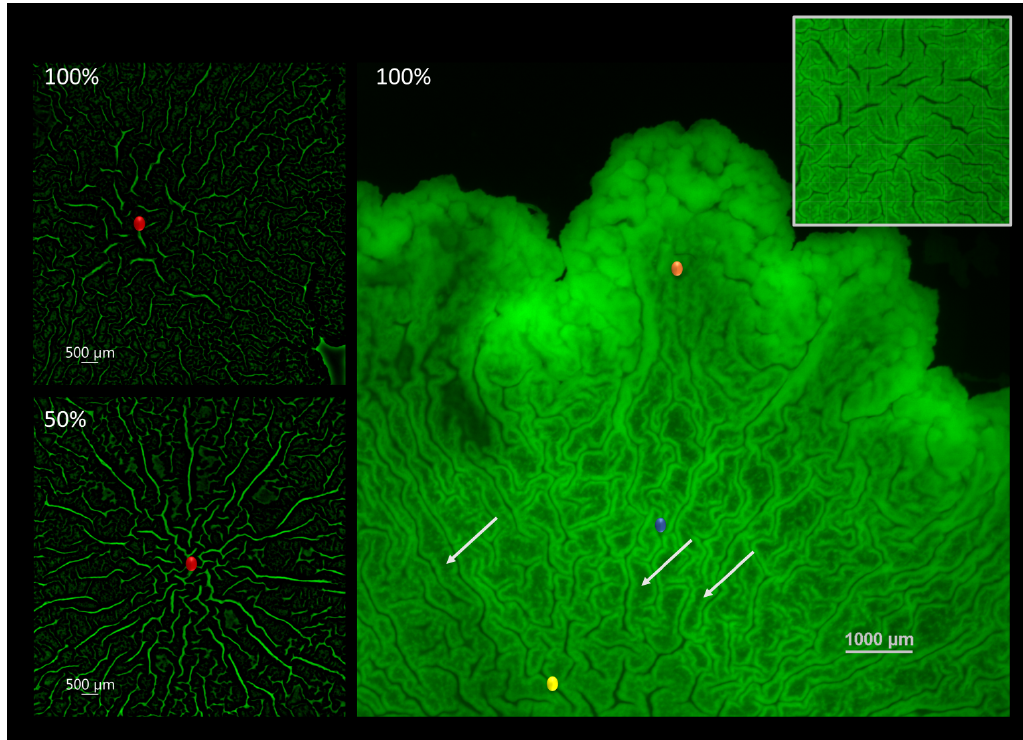
Figure 1. Channel connectivity and organization at the biofilm-agar interface. ( left ) Computerized rendering of a fully nutritional ( top ) and 50% ( bottom ) nutrient-depleted colony core of B. subtilis biofilm at the biofilm-agar interface. Center of the colony core is marked in red. ( right ) Contact surface of a fully nutritional B. subtilis biofilm. Closeup of the central zone is shown in the top right corner. Several light arrows point to examples of filament-like structures. Scale bar 1000 µ